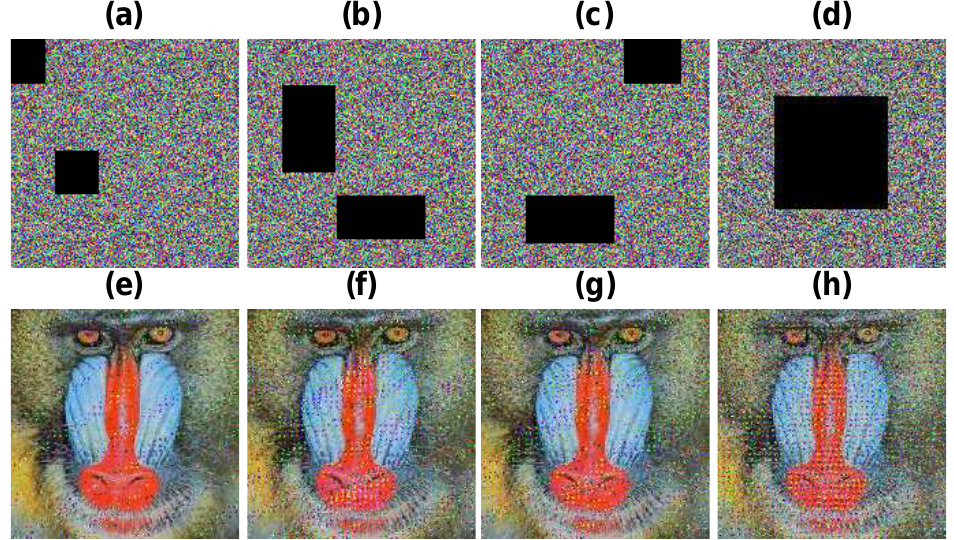
Figure 16. Occlusion attacks: ( a ) 10% occluded image, ( b ) 20% occluded image, ( c ) 25% occluded image, ( d ) 50% occluded image, ( e – h ) show the corresponding decrypted images.